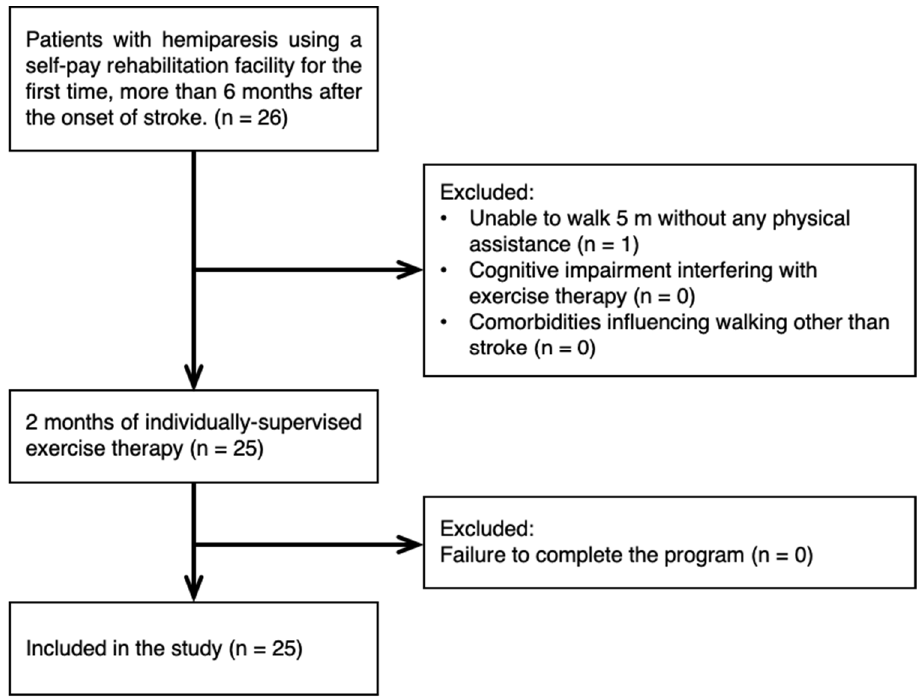
Figure 1. Flow chart of inclusion and exclusion process. Table 1. Demographic data of the subjects.